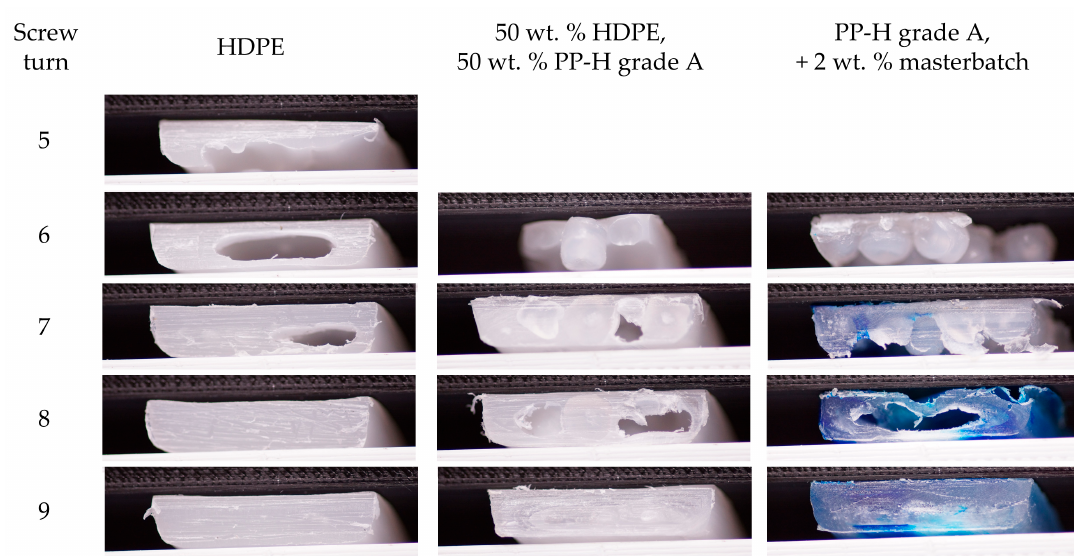
Figure 13. Results of the screw pull out experiments at a screw speed of 120 min − 1 when processing pure PP-H, grade A, pure HDPE and a mixture of 50 wt.% PP-H, grade A, and 50 wt.% HDPE using a blue masterbatch.